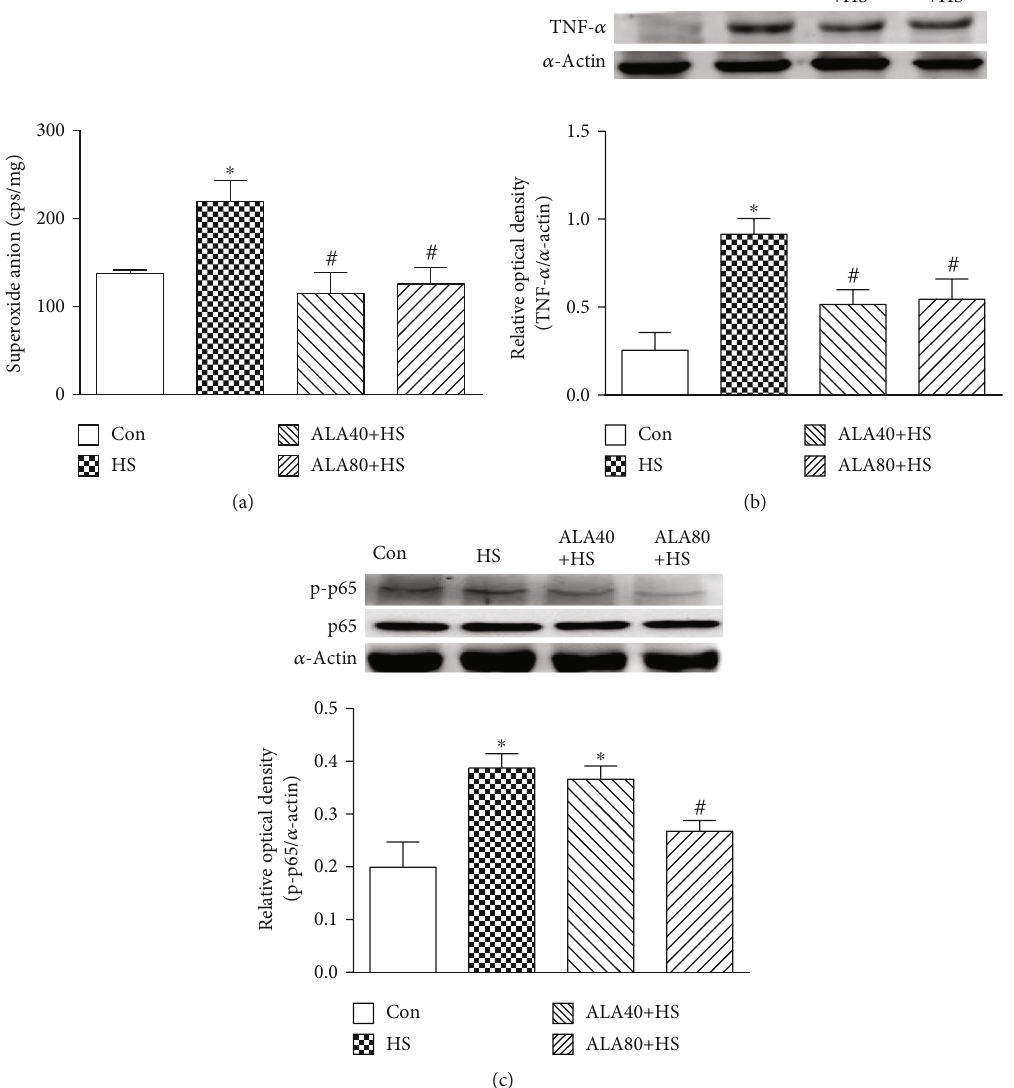
Figure 5: E ff ects of pretreatment with α -lipoic acid (ALA) on (a) superoxide anion formation and (b) TNF- α and (c) NF- κ B p-P65 protein expression in the myocardium of heat stroke rats. Data are expressed as mean ± SEM ( n = 5 -8). ∗ P < 0 : 05 versus Con; # P < 0 : 05 versus